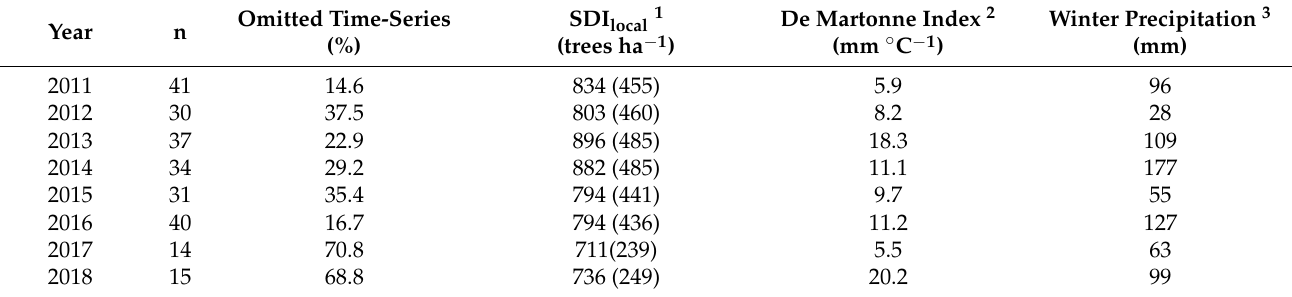
Table 2. Measurements information and parameters included in the